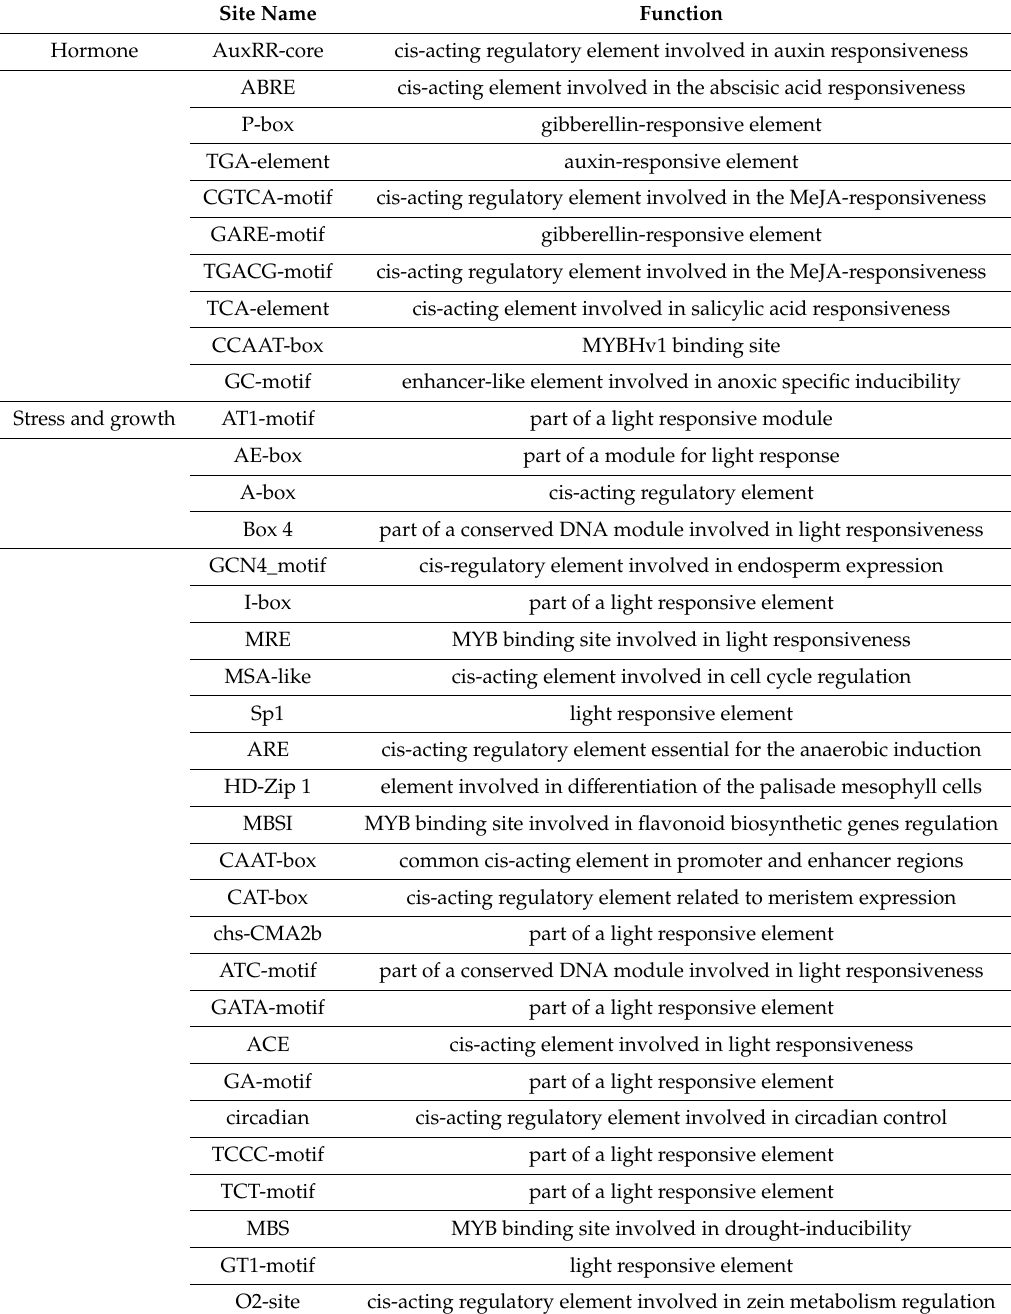
Table 4. Types and number of cis-acting regulatory elements analysis involved in the growth, development, stress and hormonal